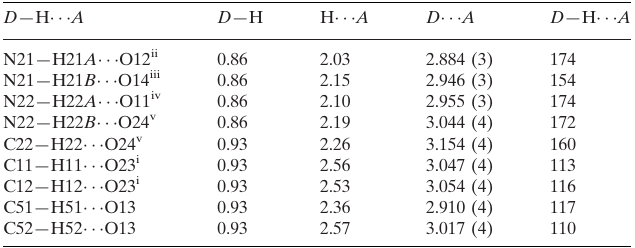
Hydrogen-bond geometry (A˚ , (cid:2)